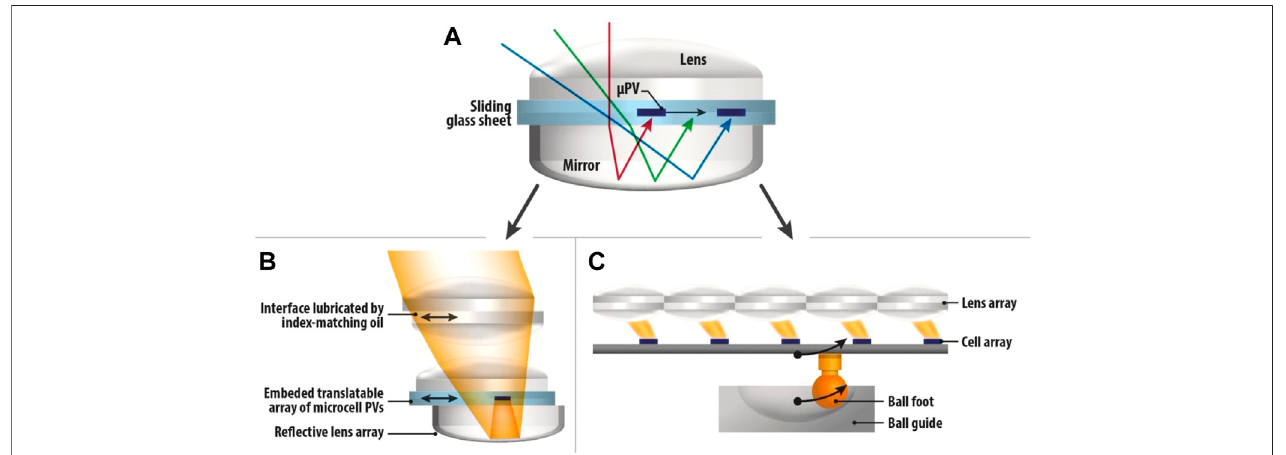
FIGURE 2 | (A) Ray tracing diagram showing the capability of the middle glass sheet in sliding to align the cell with the focal spot at different angles (Price et al., 2017). (B) Increased concentration due to the additional stack and movement of lenses in a curved trajectory relative to each other (Johnsen et al., 2019). (C) XY and complimentary Z movement of the cell array is controlled by a ball foot and ball guide combination (Ito et al.,